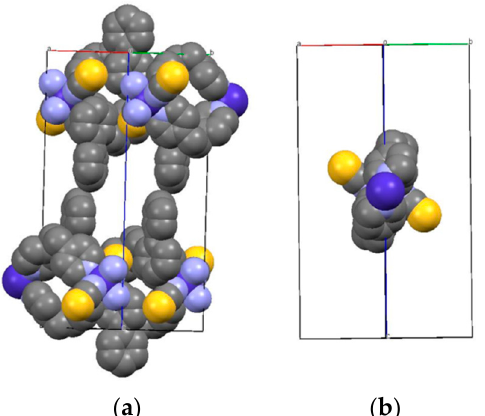
Figure 4. Space-filling view of [[Fe(NCS) 2 (bpa) 2 ] · biphenyl] n . Upper and lower 1D chain sheets and guest biphenyl are shown in ( a ) and middle 1D chain is shown in ( b ).